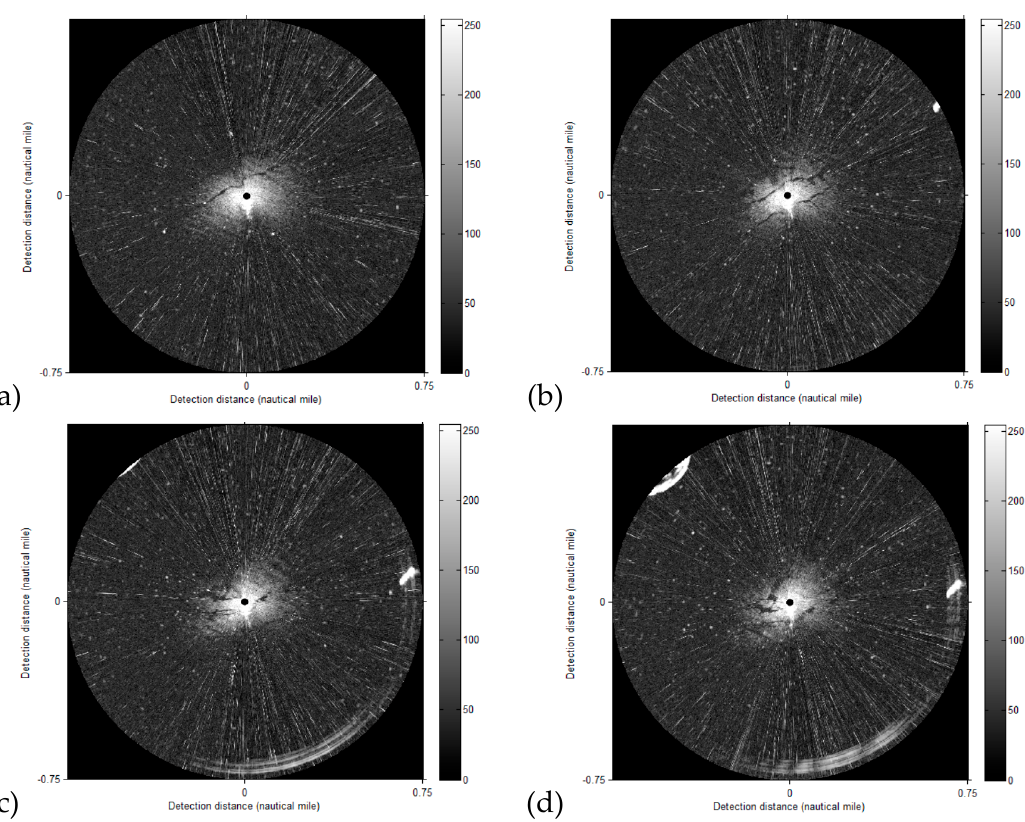
Figure 3. Primary experimental images of 68 oil spill radar images during the cleanup of the Dalian “7-16” oil spill accident. ( a – d ) were collected at 23:19:11, 23:19:43, 23:20:57, and 23:21:09, respectively.